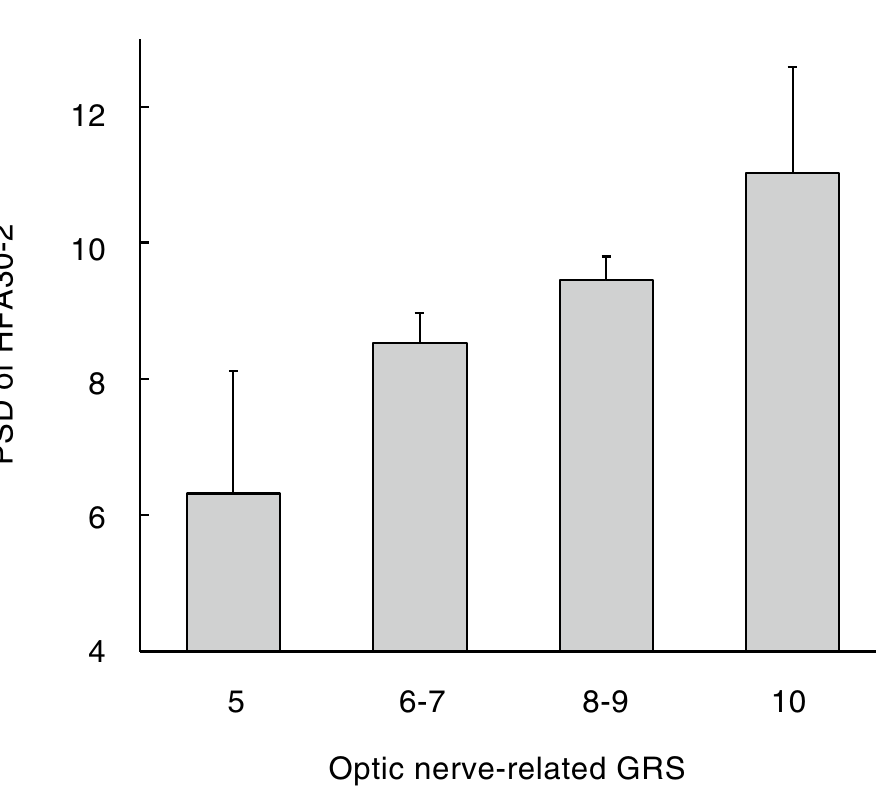
Figure 2. Mean PSD values of automated static perimetry (HFA30-2) in the worse eye divided by the GRS of optic nerve-related genetic variants in patients with primary open-angle glaucoma. As the GRS of optic